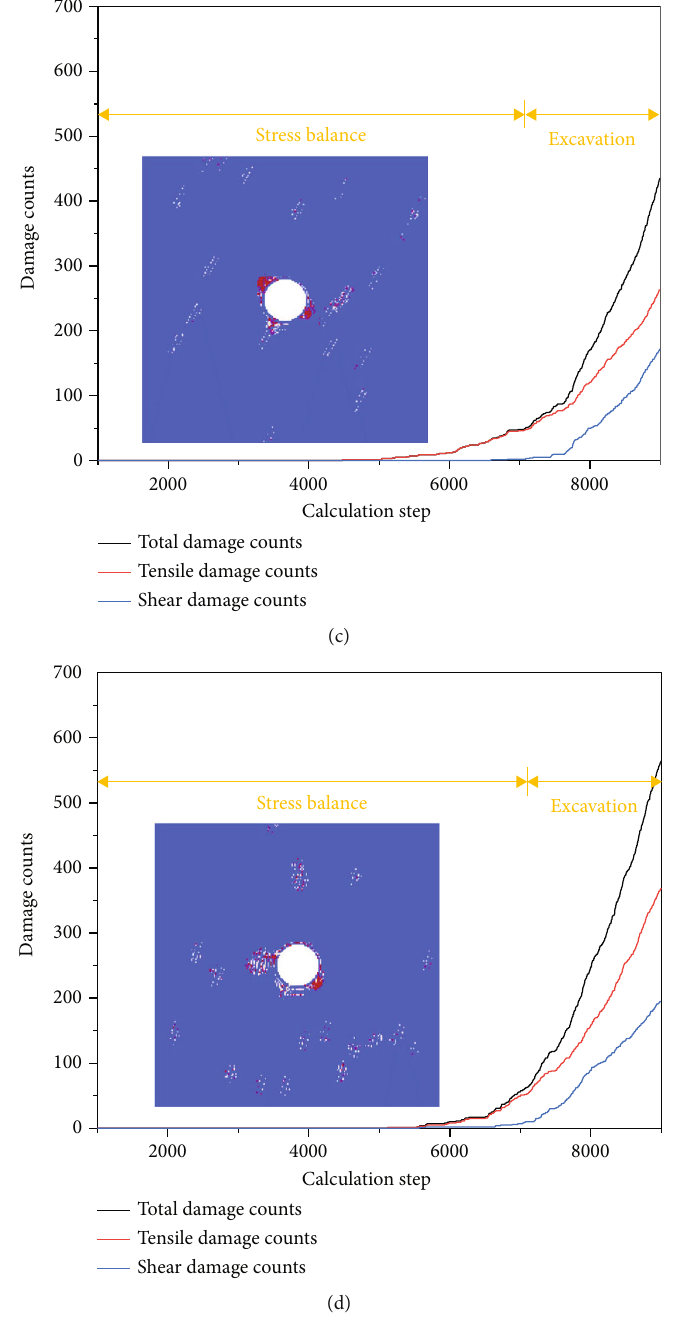
Figure 8: Excavation damage counts under di ff erent fi ssure dip angles. (a) α = 15 ° . (b) α = 45 ° . (c) α = 60 ° . (d) α = 75 °